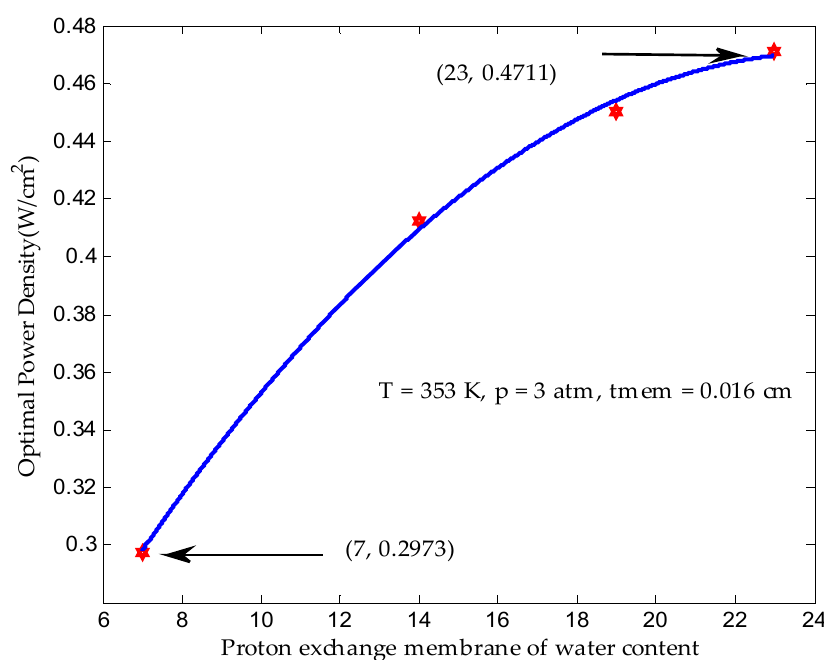
Figure 6. Optimal output power density varying with membrane water content.